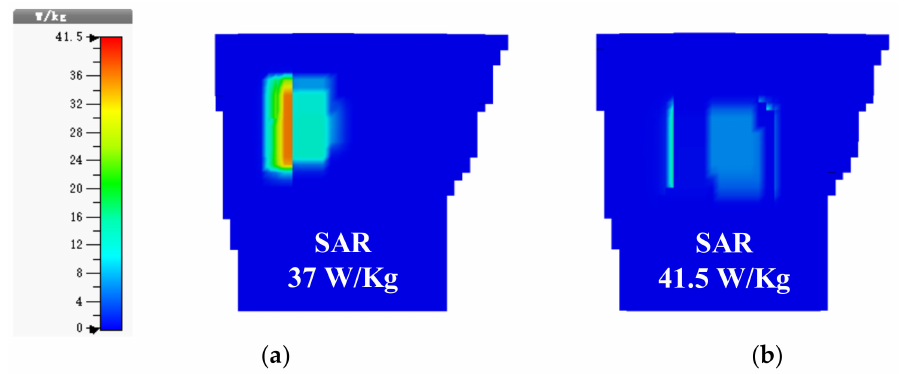
Figure 10. Simulated SAR distributions for 10-gram tissues at ( a ) 915 MHz and ( b ) 2.45